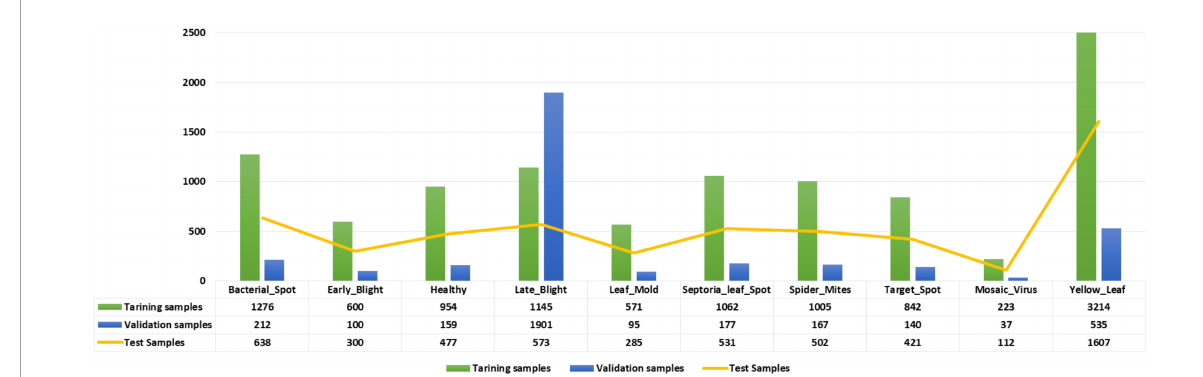
FIGURE4 Details of the tomato plant samples from the PlantVillage dataset.